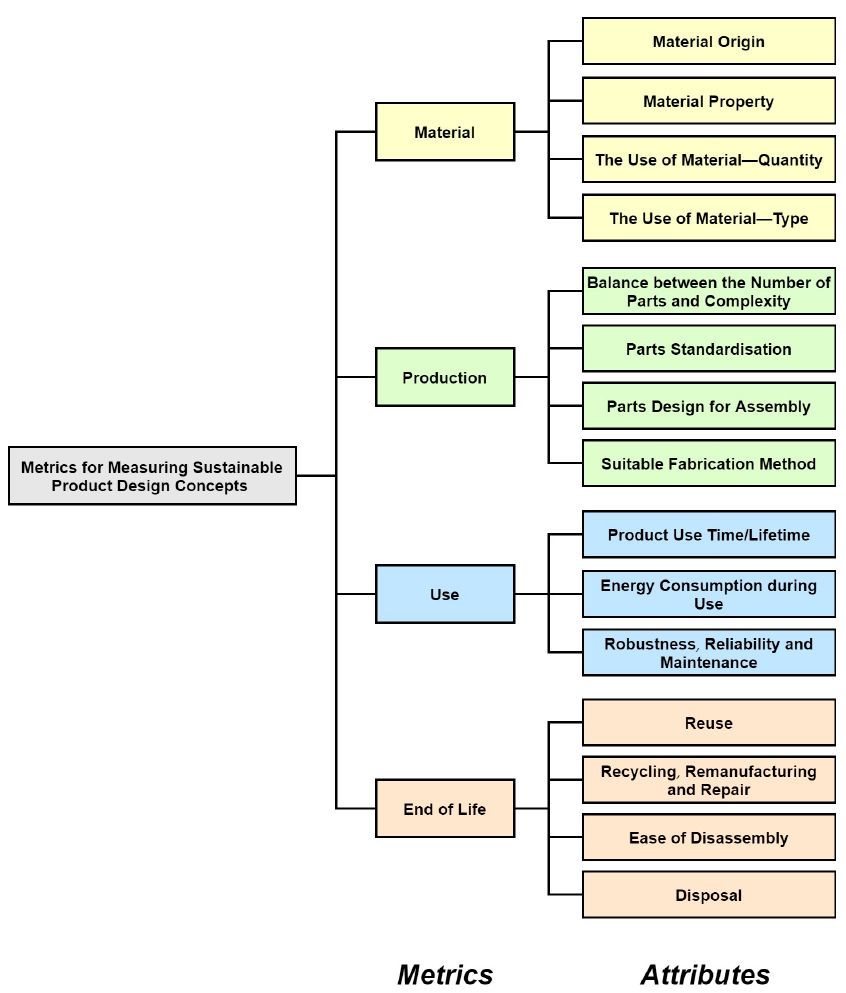
Figure 2. Metrics and attributes for measuring sustainable product design